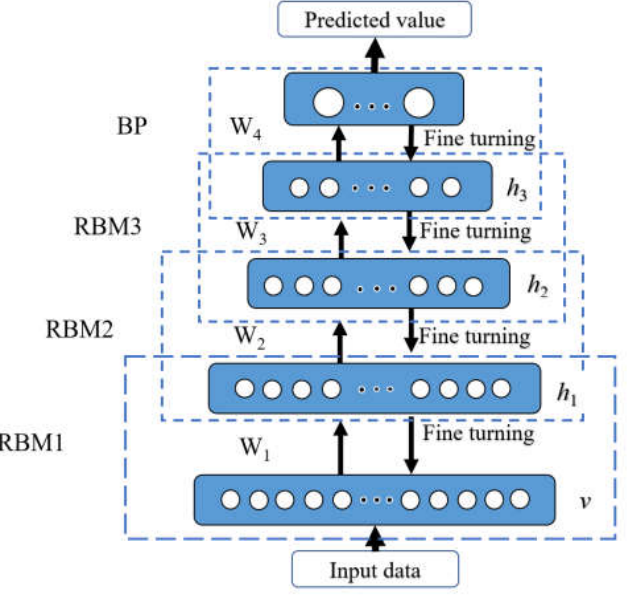
Figure 6. A prediction model based on the deep belief network (DBN).